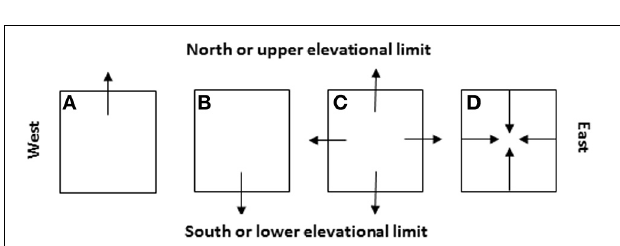
the right side. (B) The direction and magnitude (indicated by the arrows and their lengths, respectively) of shifts in abundance depend on where in the niche space the species is introduced (i.e., the positions of triangles) as shown by three newly introduced species as examples (a–c) although the niche space may also shift poleward under climate warming.